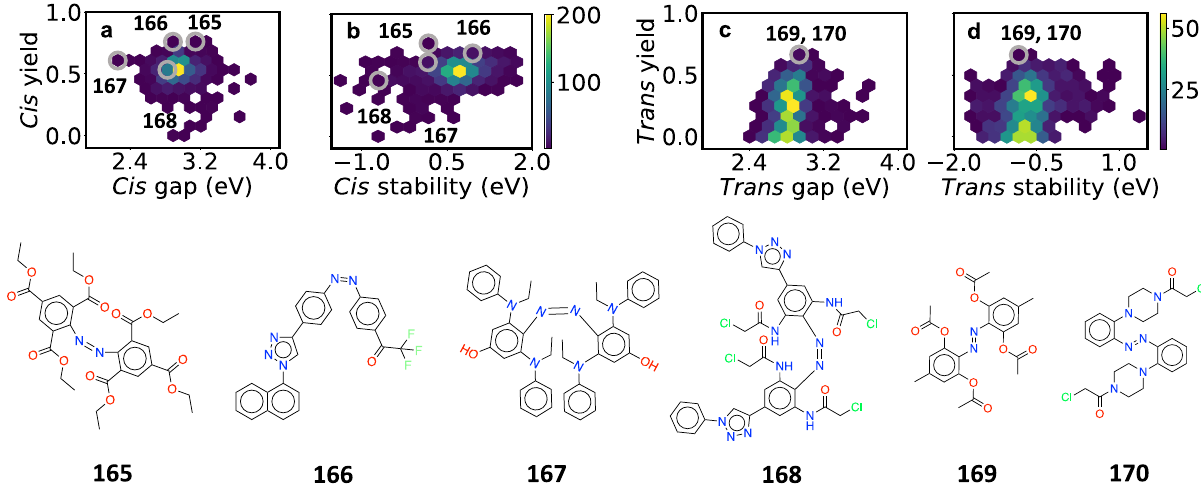
Fig. 4 Results of virtual screening. Species of interest are circled in gray and shown below the plots. a Predicted yield vs. excitation energy for cis derivatives. b Predicted yield vs. stability for cis derivatives. c - d As in ( a - b ), but for trans